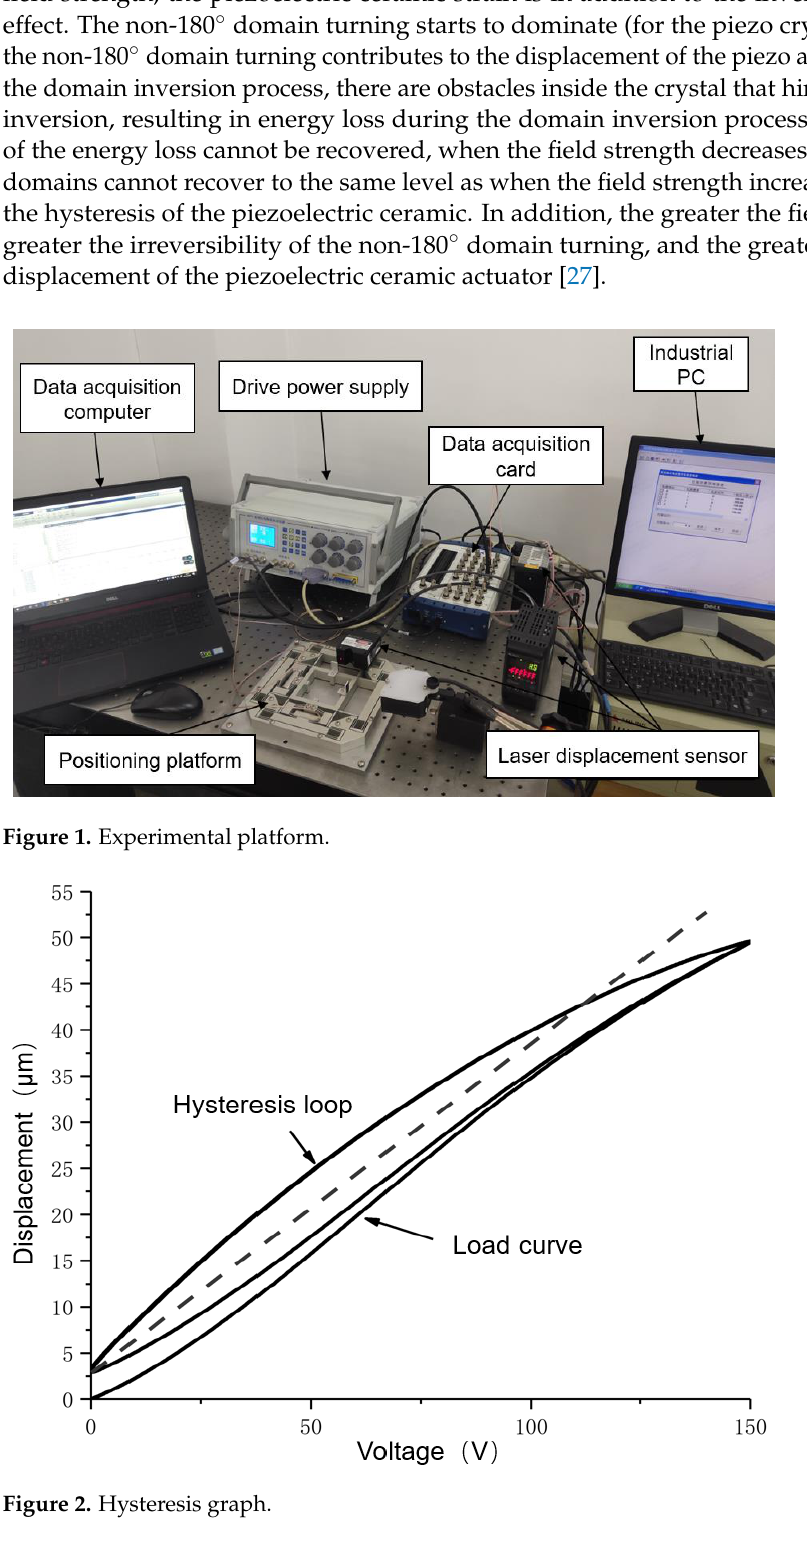
Figure 2. Hysteresis graph.